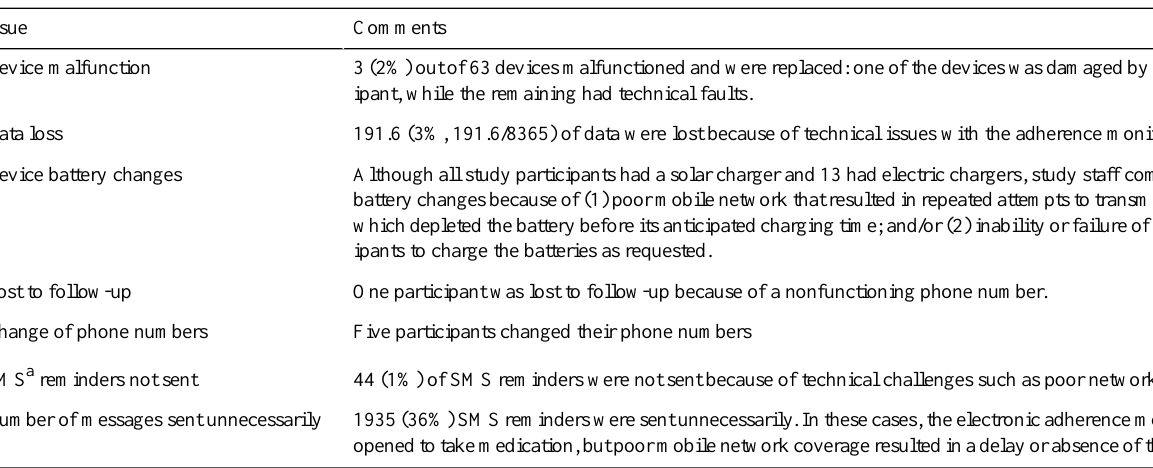
Table 2. Technical feasibility of the electronic adherence